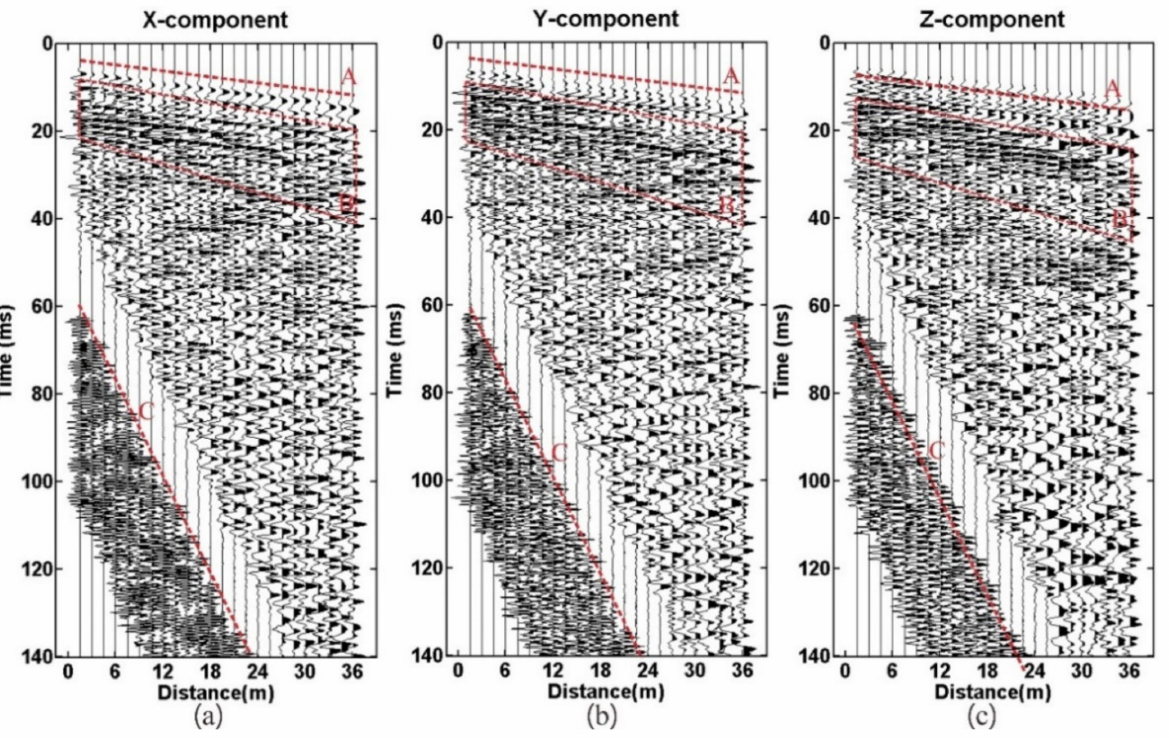
Figure 9. Geophone R-2: ( a ) X-component; ( b ) Y-component; ( c )